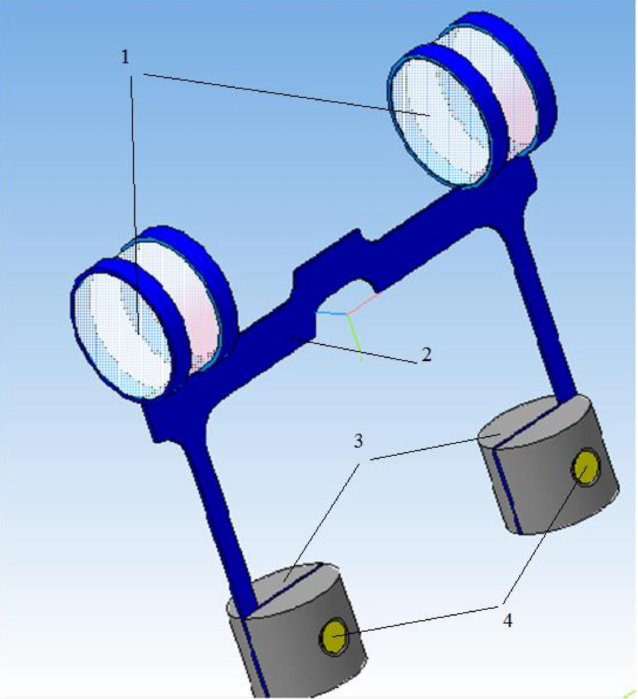
Figure 3. 3D model of the sensing element. 1—cylindrical lens; 2—plane-parallel H-shaped spring, 3—adjustment unit,